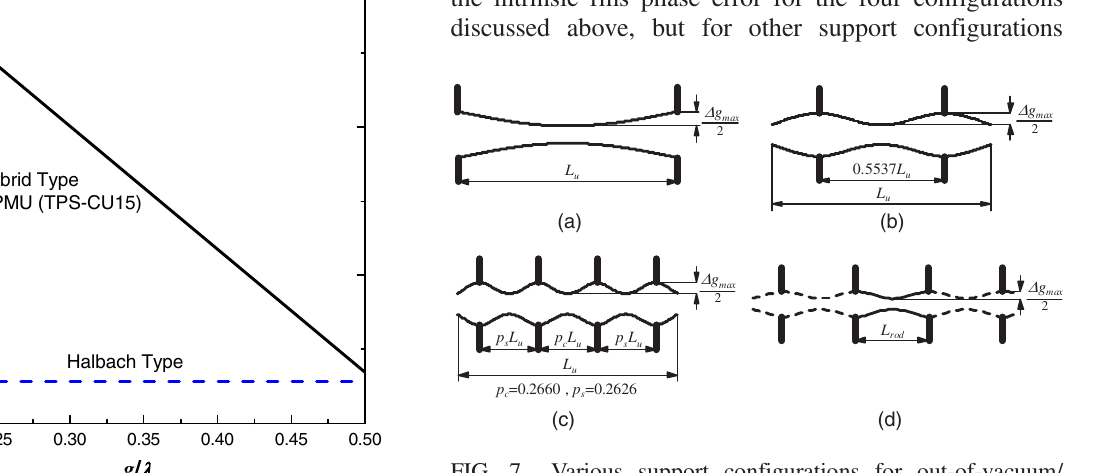
FIG. 7. Various support configurations for out-of-vacuum/ in-vacuum girders: (a) two pinned joints at both ends, (b) two pinned joints at optimum points for minimum deviation, (c) four pinned joints at optimum points for minimum deviation, and , u (d) many pinned joints at regular